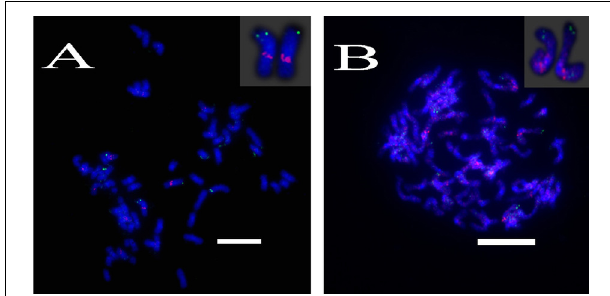
FIGURE 4 | FISH mapping of BAC-24, BAC-66, BAC-78 on SsChr1 in S. spontaneum . (A) BAC-24 and BAC-66 probes labeled with biotin (green) and digoxigenin (red); (B) BAC-78 and BAC-66 probes labeled with biotin (green) and digoxigenin (red). Scale bars = 10 µ m.